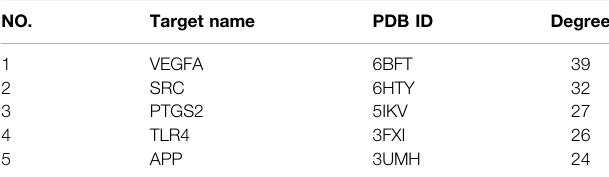
TABLE 4 | The top fi ve targets in PPI network.